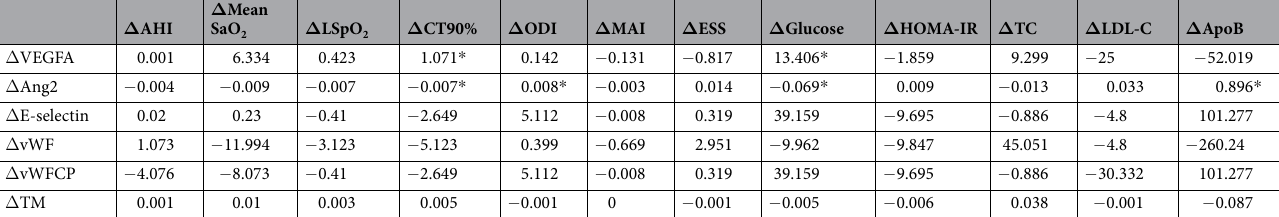
Table 6. Multivariable linear regression analyses with changes in serum levels of 10 markers, PSG parameters and biomarker levels. Abbreviations: VEGFA = vascular endothelium growth factor A, Ang2 = angiopoietin-2, E-selectin = endothelial-leukocyte adhesion molecule, vWF = von willebrand factor, vWFCP = von willebrand factor cleavage protease, TM = thrombomodulin, AHI = apnea-hypopnea index, SaO 2 = oxygen saturation, LSpO 2 = lowest pulse oxygen saturation, CT90 = percentage of time during which oxyhemoglobin saturation was < 90%, ODI = oxygen desaturation index, MAI = micro-arousal index, ESS = Epworth Sleepiness Scale, HOMA-IR = homeostasis model of assessment for insulin resistance index, TC = total cholesterol,